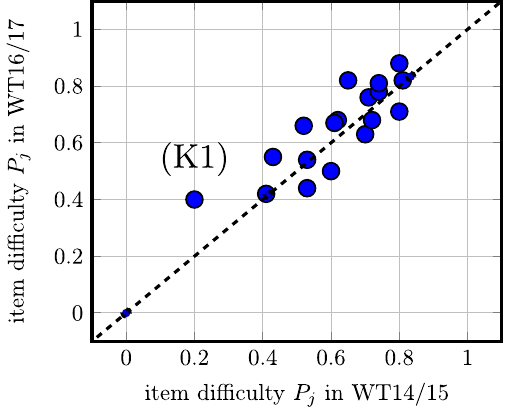
FIG. 7. KiRC item difficulties obtained in winter term WT14/ 15 and WT16/17. Each point represents one item (item 1 being highlighted). The dashed line represents equal item difficulties.